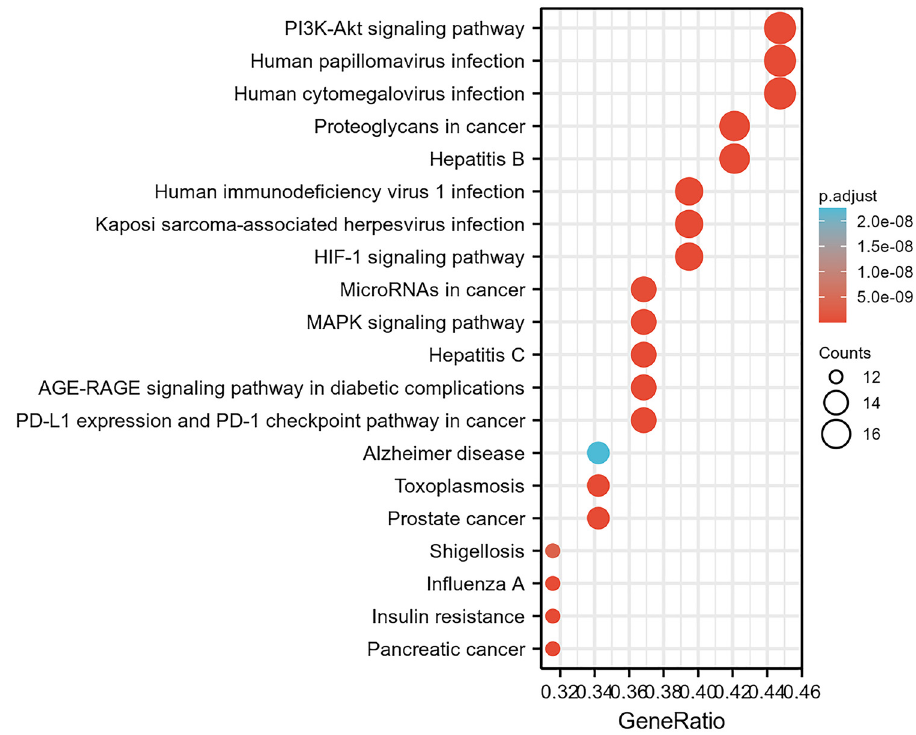
Figure 6: KEGG enrichment results. Gene ratio and pathways are represented by the x - axis and y - axis, respectively. The size and color of the dots mean the gene counts and the value of p adjust,